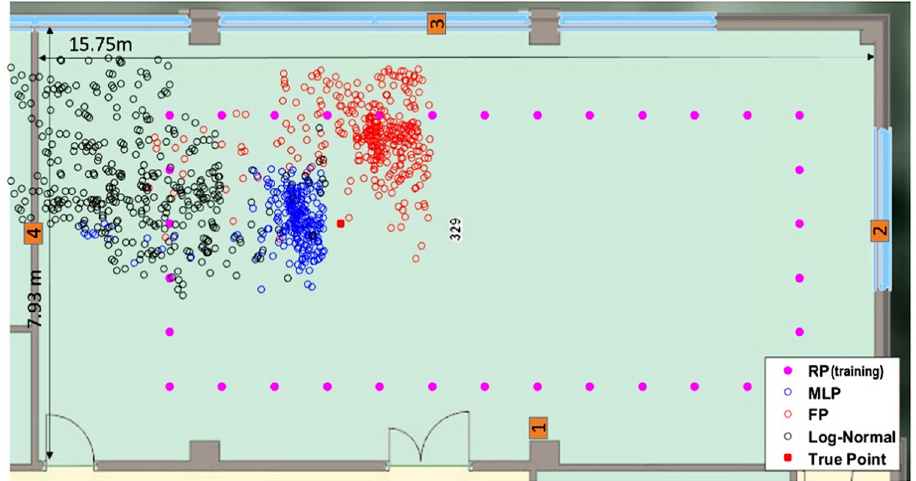
Figure 20. A comparison of the positioning results between the fingerprinting (FP) method, the proposed MLP algorithm with vision information, and the uncorrected log-normal method.